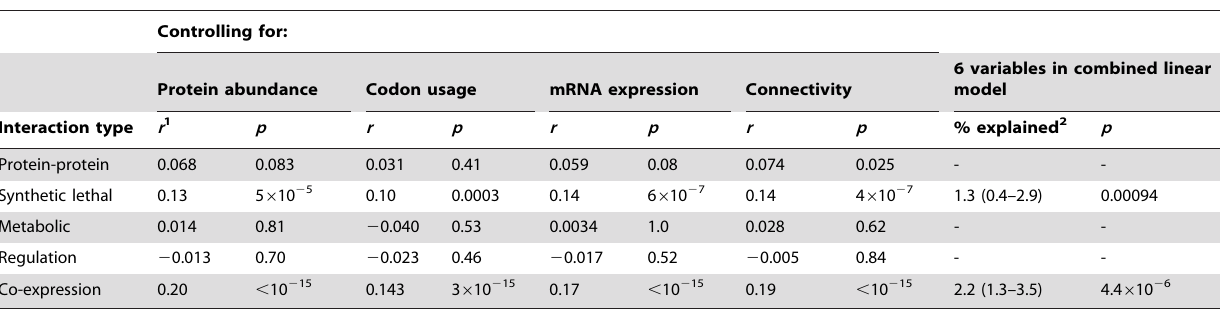
Table 2. Correlation between dN and average dN of the neighbours after controlling separately for protein abundance, codon usage (CAI), or mRNA expression level; and after simultaneously controlling for all three expression measures and for protein length, gene essentiality, and network connectivity using a linear